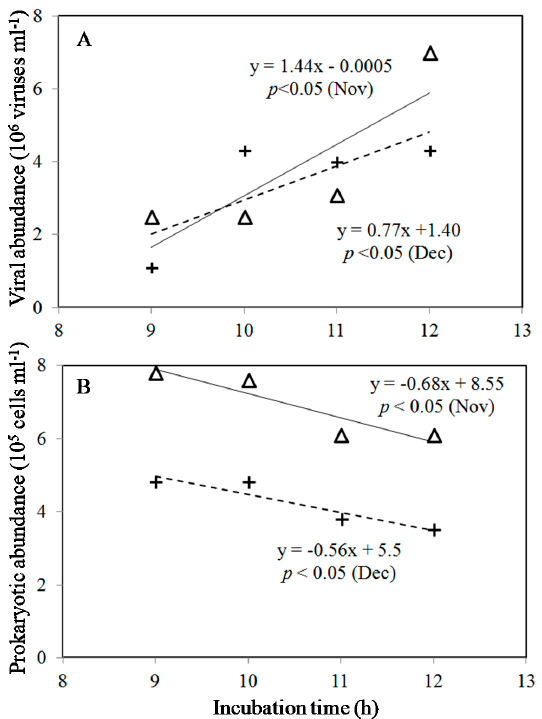
Figure 2. Relationships between viral abundance ( A ), prokaryotic abundance ( B ), and incubation time between 9 h and 12 h in November ( △ ) and December (+). (—) and (– –) are regression lines time between 9 h and 12 h in November ( (cid:52) ) and December (+). (—) and (– –) are regression lines for for November and December. November and